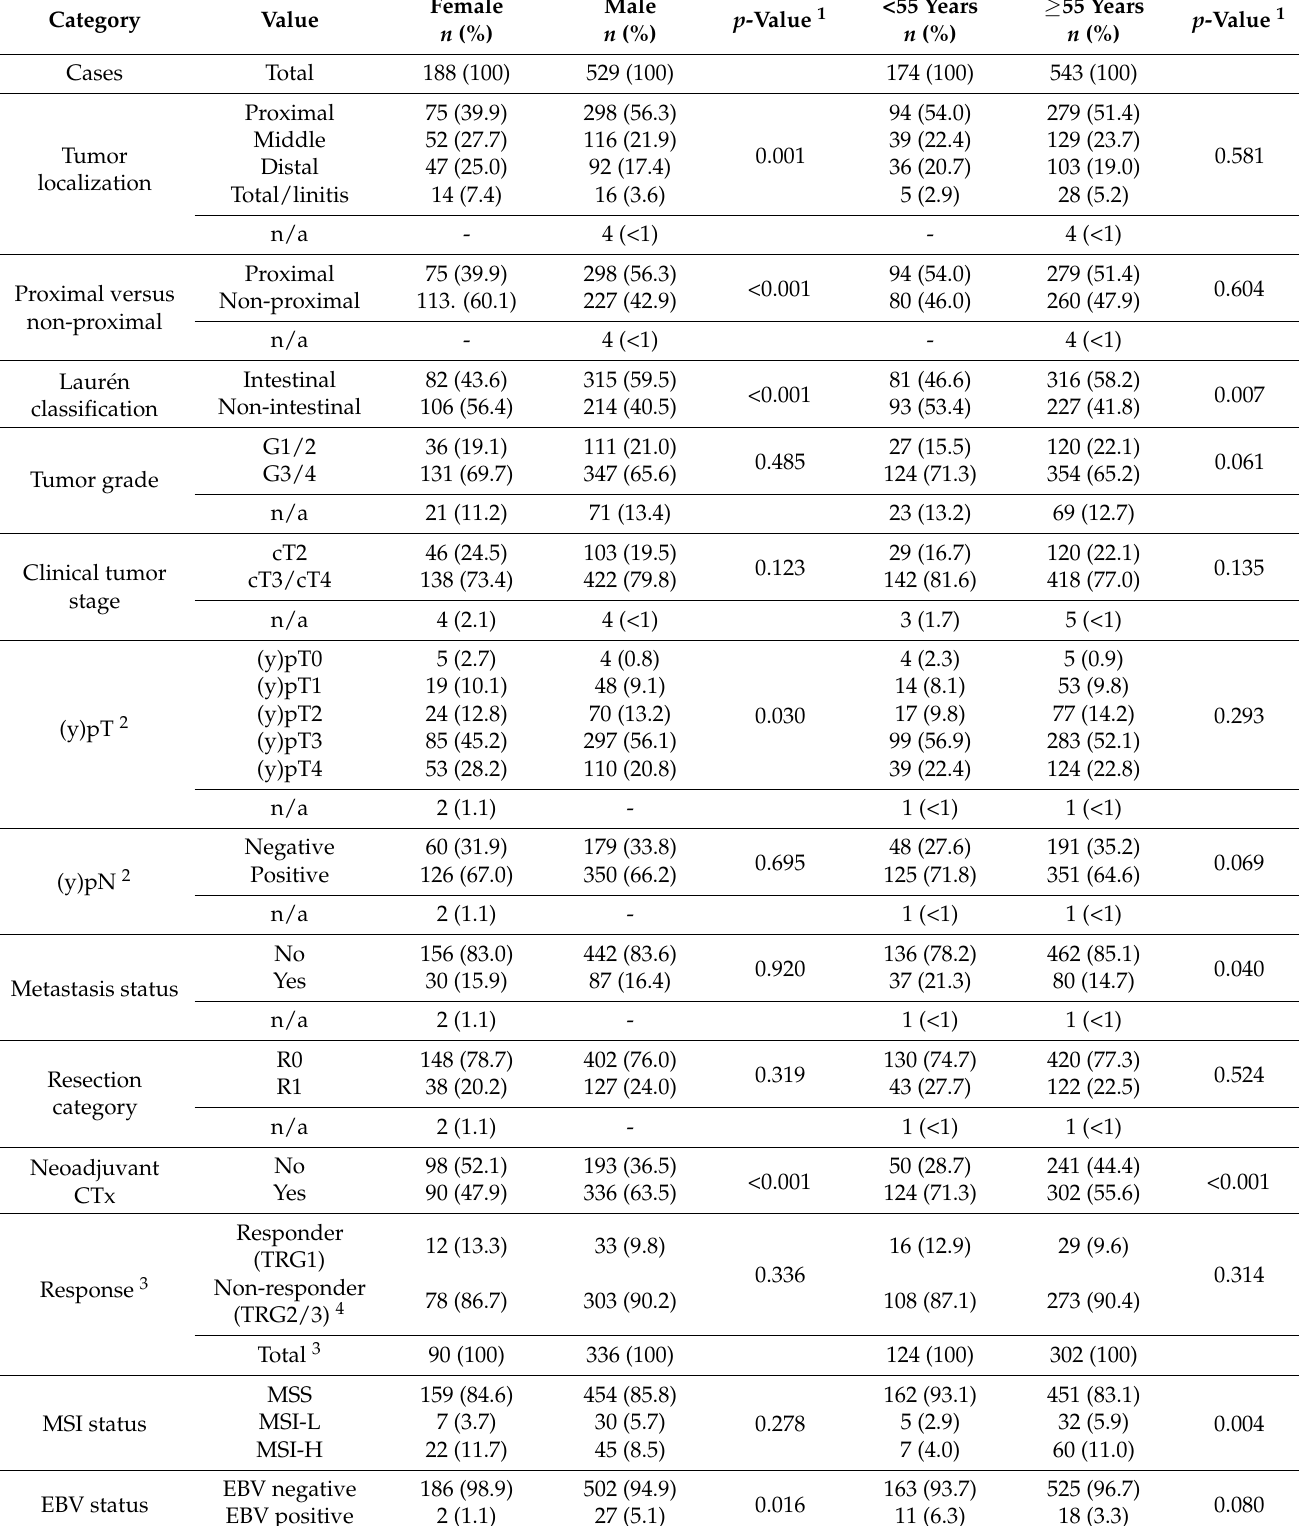
Table 1. Clinical-pathological characteristics of the patients stratified according to sex and